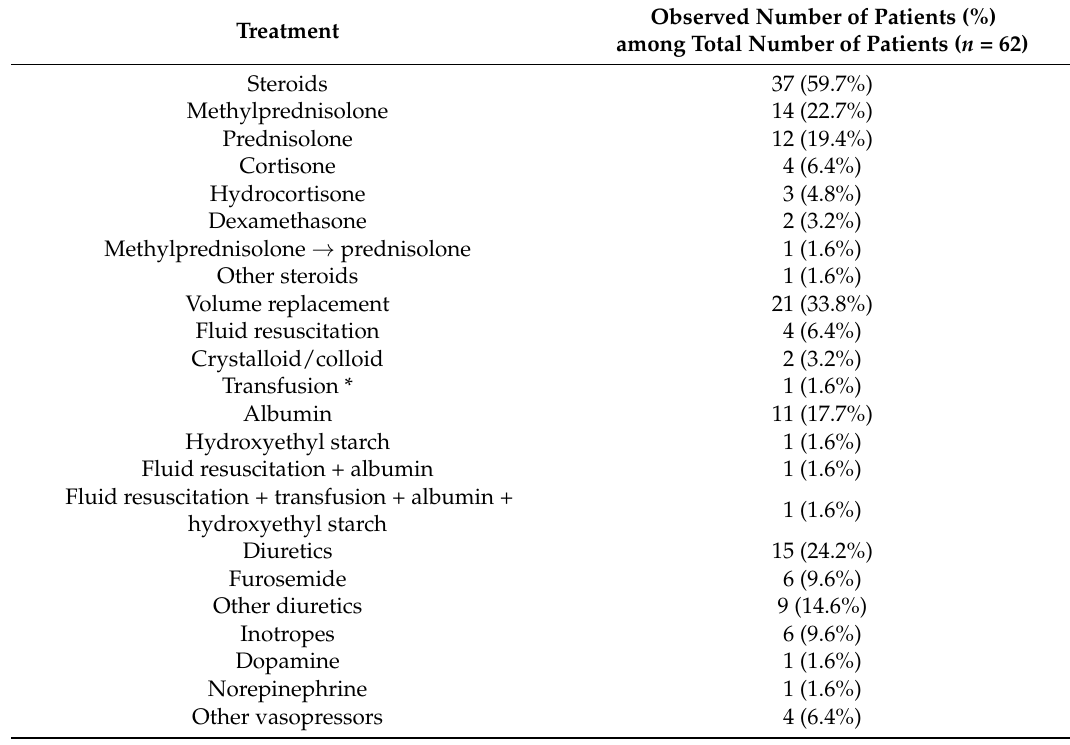
Table 5. Treatment of cancer patients with systemic capillary leak